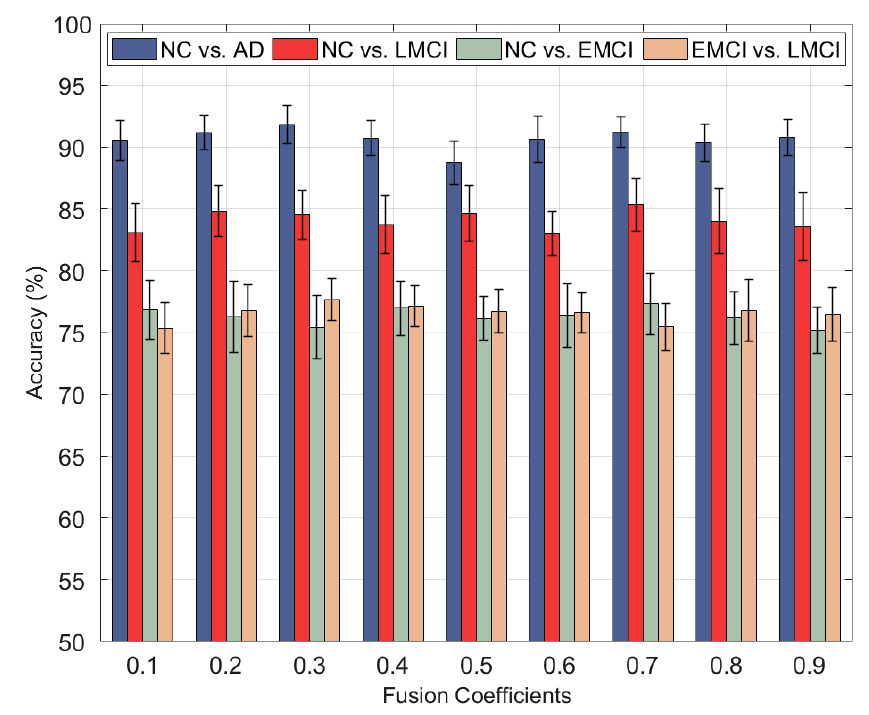
Figure 3. Influence of different fusion coefficients on classification accuracy.